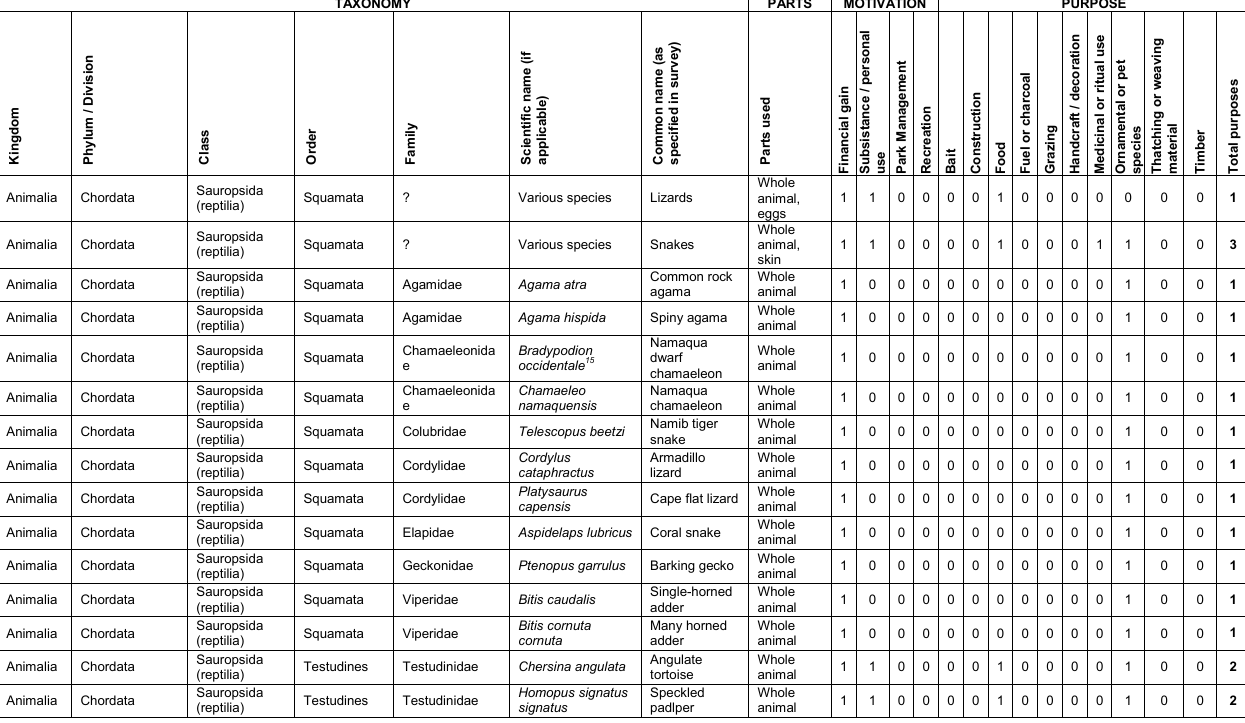
15 Synonym Bradypodion ventrale occidentale, Lophosaura ventralis